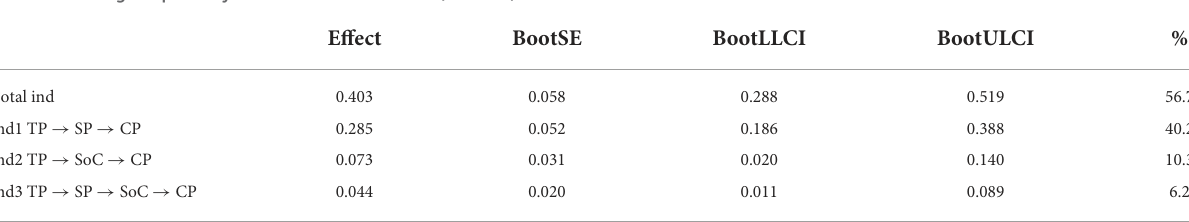
TABLE 3 Testing the pathways of the mediation model (N =